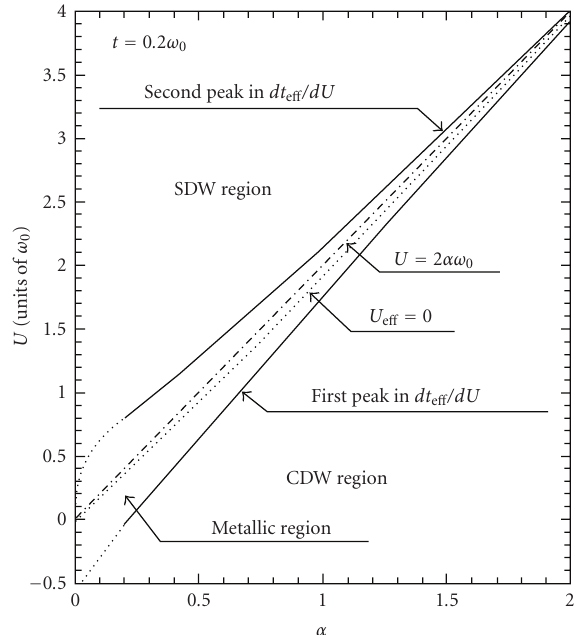
Figure 3: Phase diagram in ( α , U ) plane determined by the peaks in dt e ff /dU . The curve corresponding to U e ff = 0 is also given by the dotted curve.